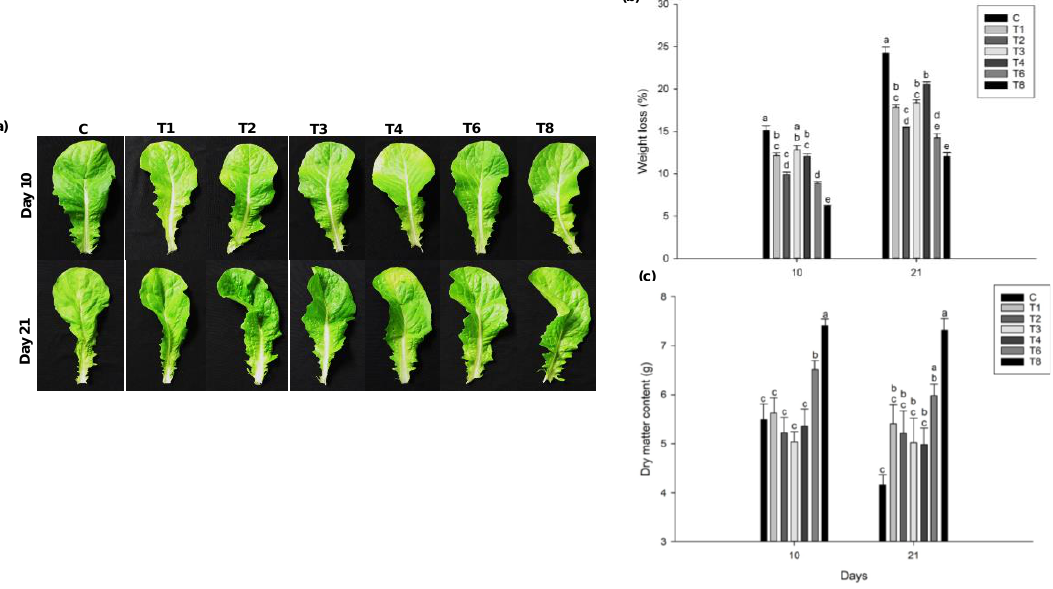
Figure 2. Effect of pretreatment of ANE and HA on fresh weight loss and dry matter content during postharvest storage of lettuce. ( a ) This figure represents leaves of lettuce treated with different concentrations of ANE and HA alone, and their combinations held over 10 and 21 days of storage at 0–4 °C in the dark with relative humidity (RH) ≥ 95%. The post-harvest ( b ) fresh weight loss and ( c ) dry matter content (DMC) of lettuce leaves after 10 and 21 days of post-harvest storage at 0–4 °C in the dark with RH ≥ 95%. Different combinations of ANE and HA used for preharvest treatment were as follows: C (control), T1 (0.1% ANE), T2 (0.25% ANE), T3 (0.2% HA), T4 (0.4% HA), T6 (0.1% ANE + 0.4% HA), and T8 (0.25% ANE + 0.2% HA). Each experiment was performed in triplicate, and each experimental unit had six plants. The average of the eighteen values were presented as mean ±SE and means represented by same letters were not significantly different at p ≤ 0.05.